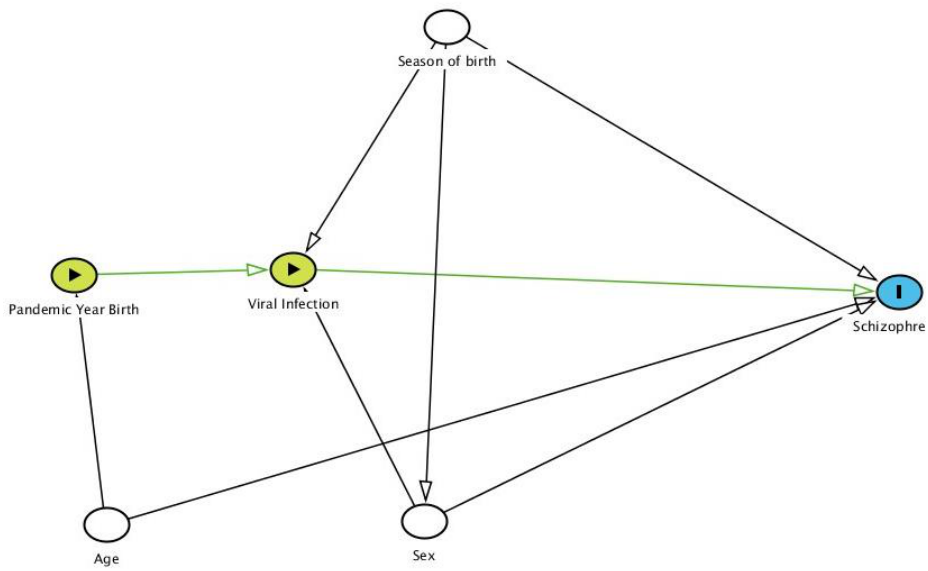
Figure 1. Directed Acyclic Graph (DAG) of the relationship of the season of birth and birth during an Influenza Pandemic, in combination with a viral infection during pregnancy (exposure), with schizophrenia (outcome). Adjusted variables (white circle). Based on DAGitty version 3.0 [32].